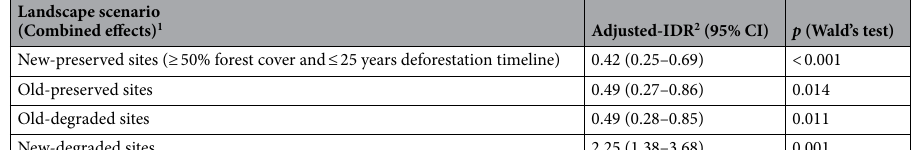
Landscape scenario (Combined effects)